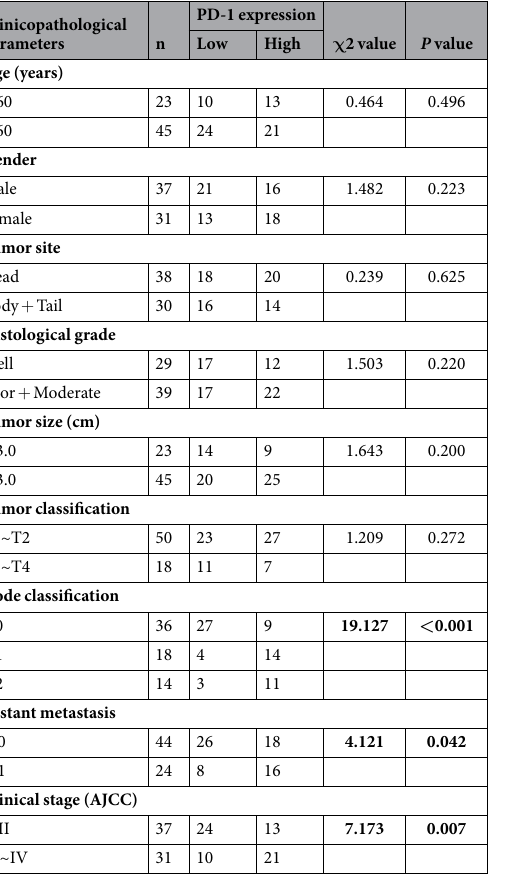
Table 3. Correlation of PD-1 expression on peripheral CD8 + T cells with major clinicopathological parameters in patients with pancreatic ductal adenocarcinoma (PDAC). The bold numbers indicate significant differences with P <